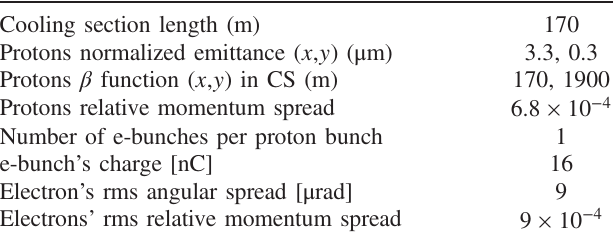
TABLE III. Parameters of the EIC cooler operating at γ ¼ 293